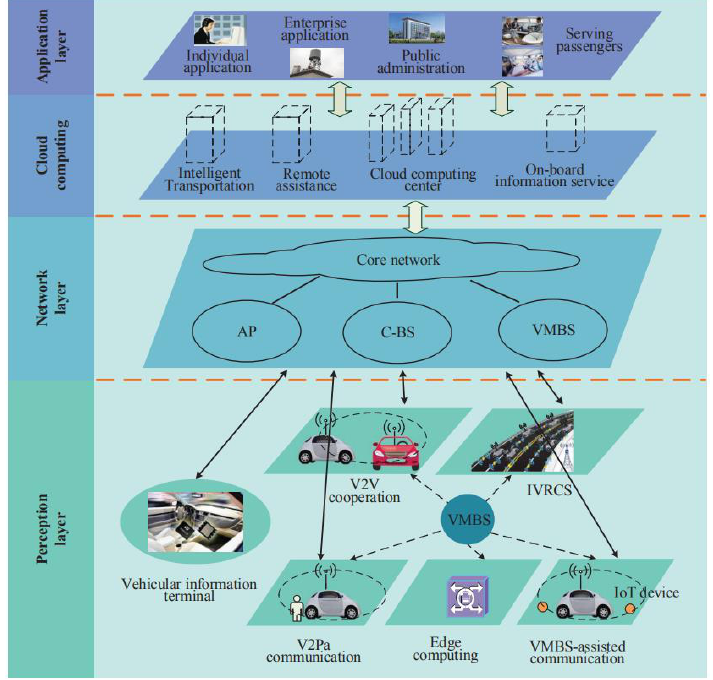
Figure 6. VMBS system communication and computing network architecture [17].